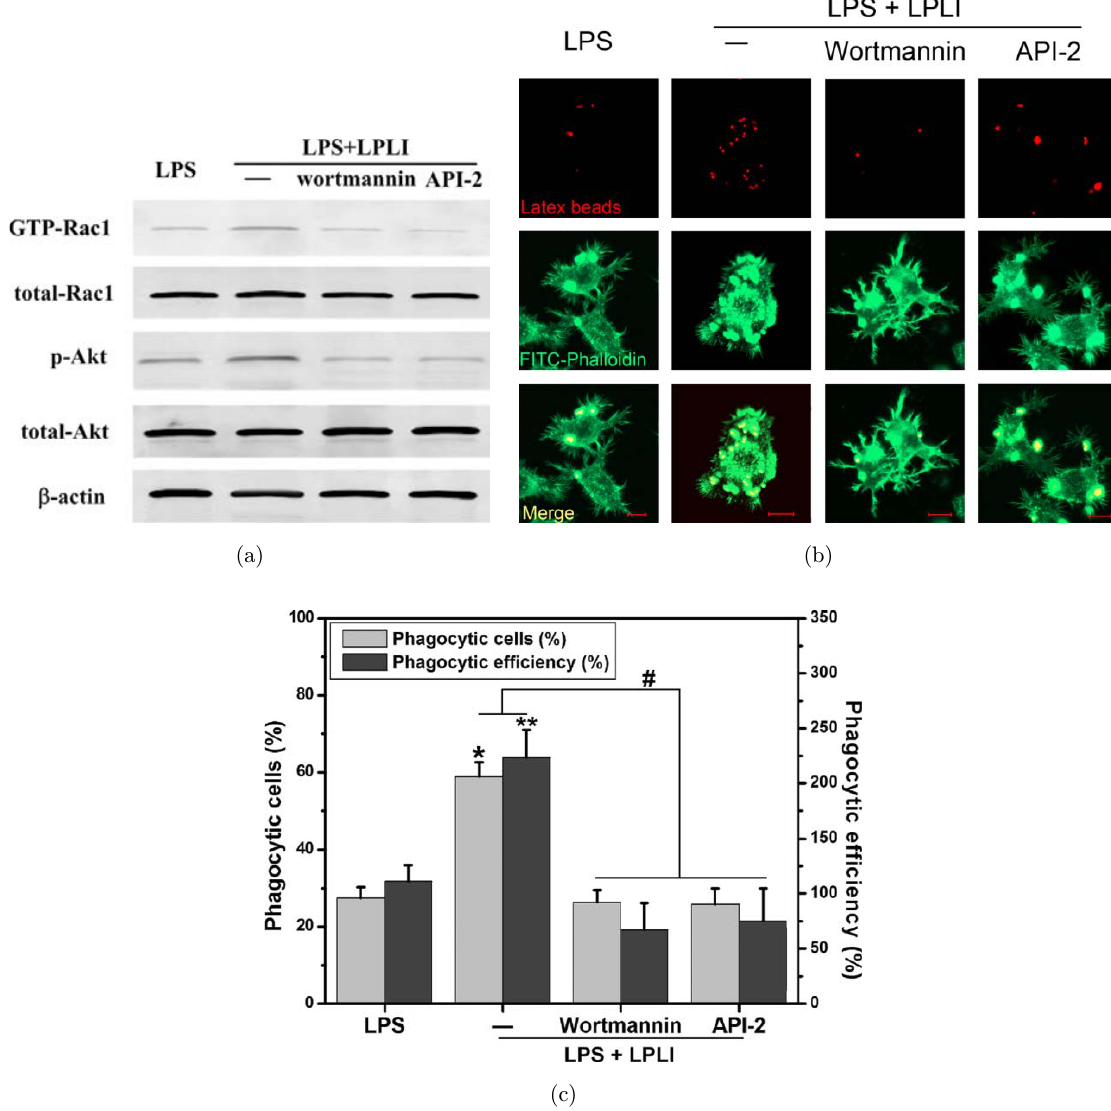
Fig. 3. LPLI-induced Rac1 activation is mediated by PI3K/Akt pathway. LPS-activated BV-2 cells pre-treated with or without wortmannin (100 nM), or API-2 (5 (cid:3) M) then subjected to LPLI (20 J/cm 2 ) treatment. (a) Representative western blot analysis of LPLI-treated LPS-activated BV-2 cells was performed to detect GTP-Rac1, total Rac1, p-Akt (ser473) and total Akt. (b) Flu- orescent images of the distinct microglial phagocytosis in BV-2 cells. Merged beads (red) and F-actin (green) are displayed in yellow (bottom). Images shown are representative of approximately 100 cells. Bar ¼ 10 (cid:3) m. (c) Quanti¯cation of LPLI-mediated microglial phagocytosis; and the number of microspheres taken up per BV-2 cell at 30 min was measured. ( n ¼ 4; * p < 0 : 05 and ** p < 0 : 05 vs corresponding control cells, p < 0 : 05 vs indicated